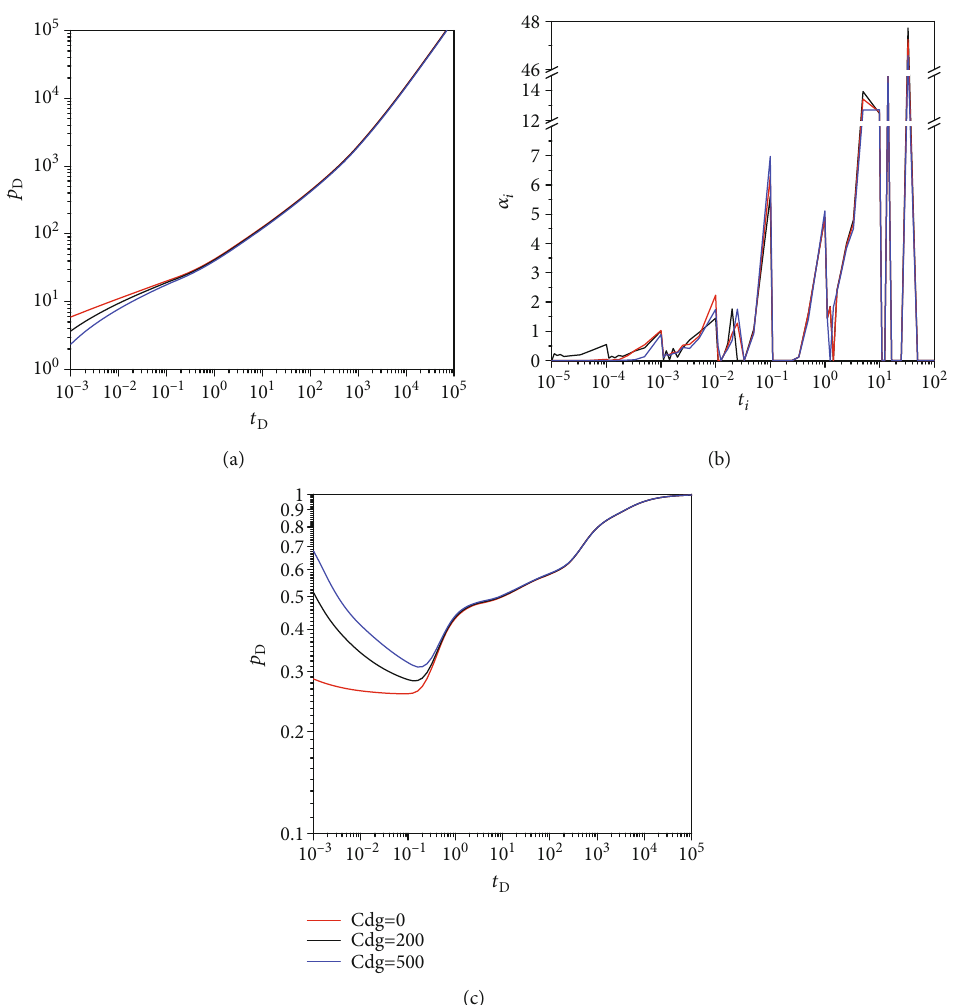
Figure 6: The wellbore dimensionless gas pressure at di ff erent values of C temporal scale